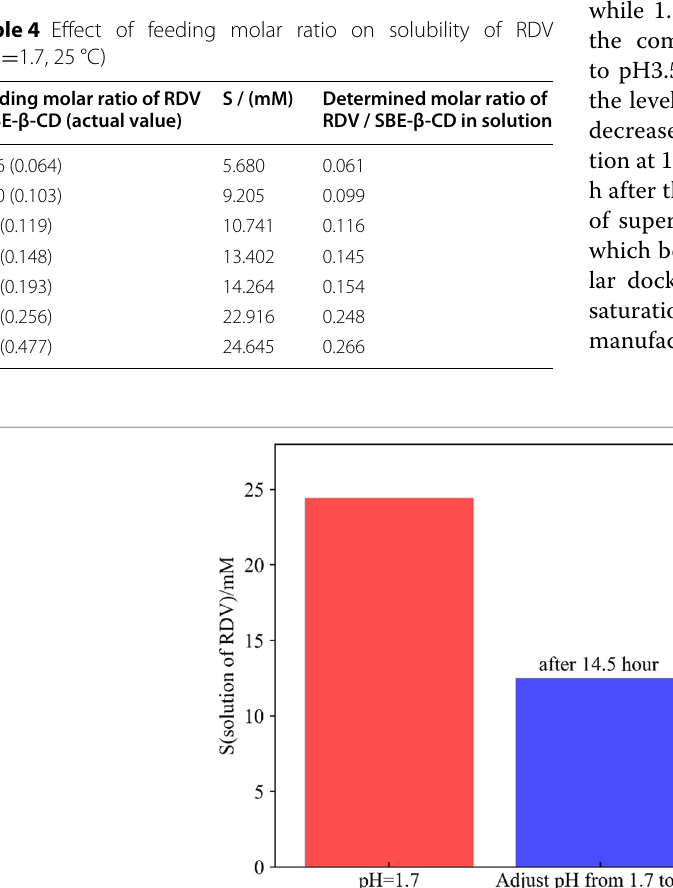
Fig. 2 Stablization of supersaturated solubility of RDV in SBE‑β‑CD at 25 °C upon the adjustment from pH1.7 to